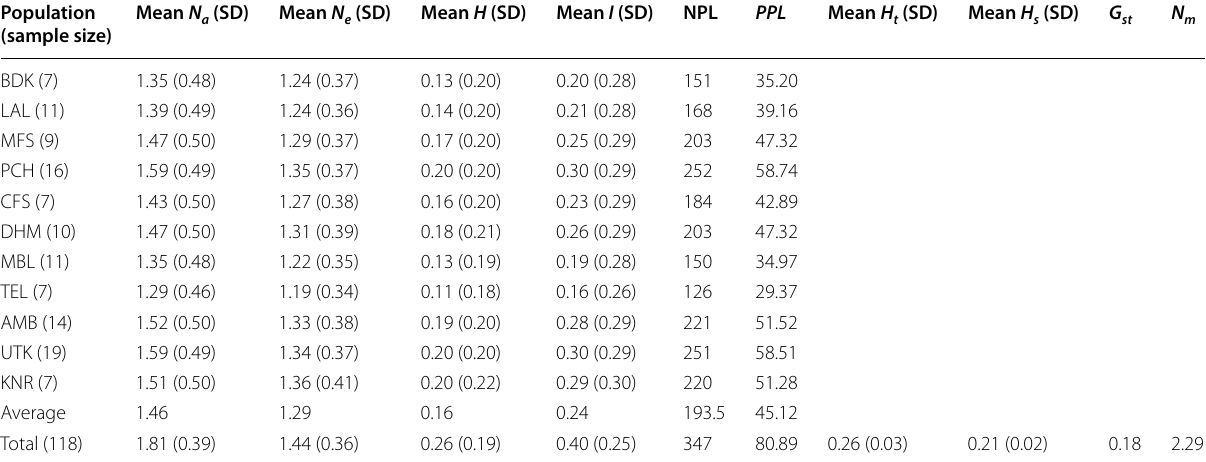
N a observed number of alleles, N e effective number of alleles, H Nei’s gene diversity, I Shannon’s information index, NPL number of polymorphic loci, PPL percentage of polymorphic loci, H t total genetic diversity, H s genetic diversity within populations, G st Nei’s genetic differentiation coefficient among populations, Nm gene flow among populations, SD standard deviation of mean values. Population codes are as given in Table 1